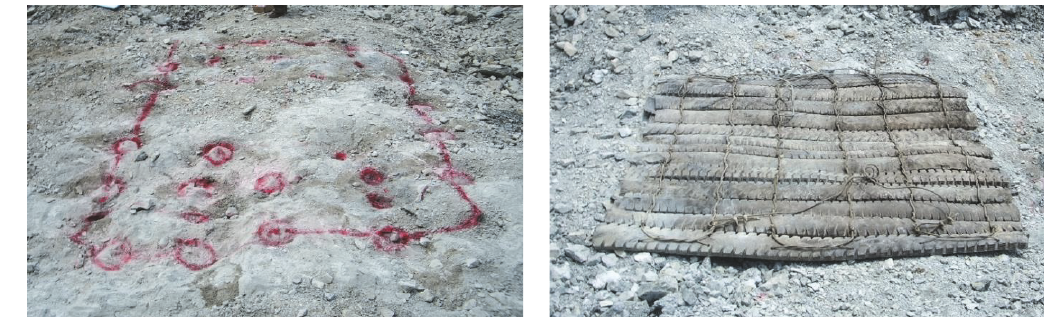
Figure 9: Preparation of blasting.